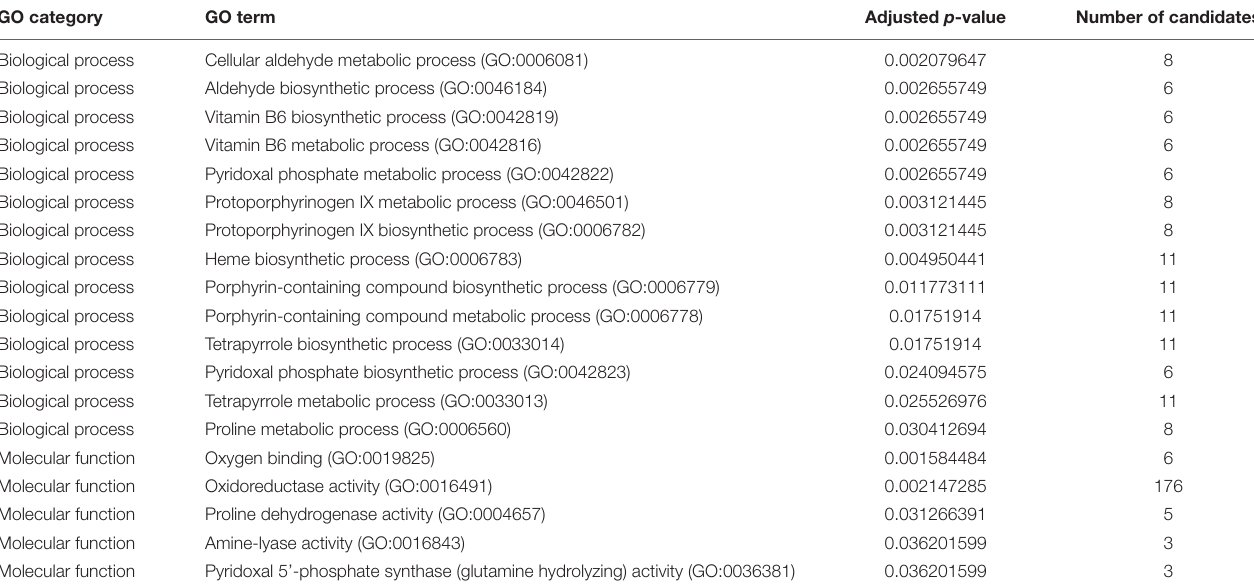
TABLE 2 | GO term enrichment of proteins encoded by genes up-regulated after fungal co-cultivation with P_DAPG for 120 min ( p -value < 0.0001 and Log 2 -fold-change >